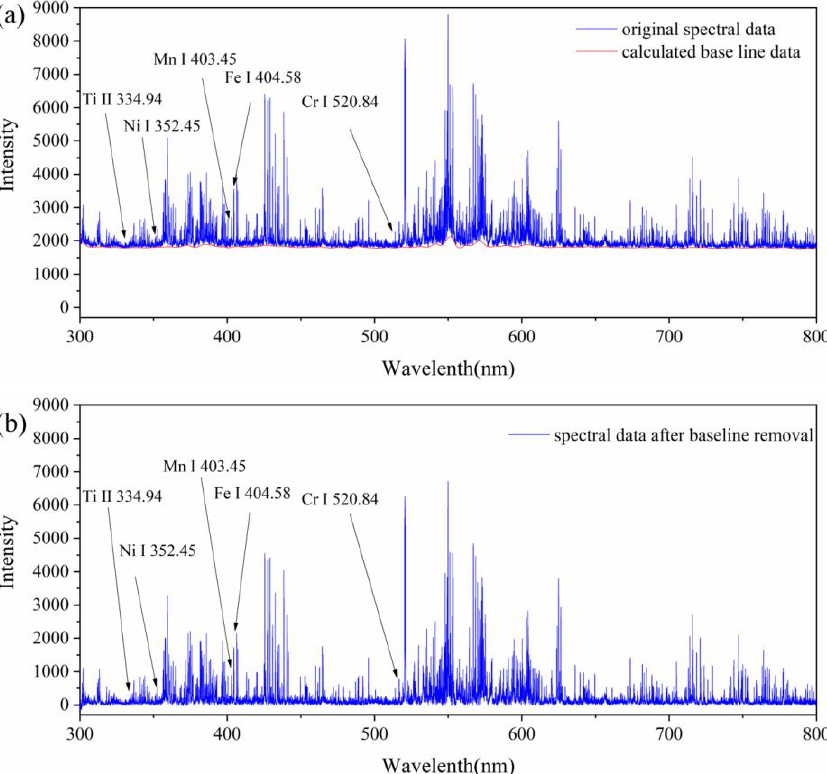
Figure 3. LIBS spectrum of sample GBW 01659a in the wavelength range of 300 – 800 nm: ( a ) the original spectral data (blue line) and calculated baseline data based on cubic spline interpolation algorithm (red line); ( b ) the spectral data after baseline removal obtained by subtracting the baseline data from the original data.